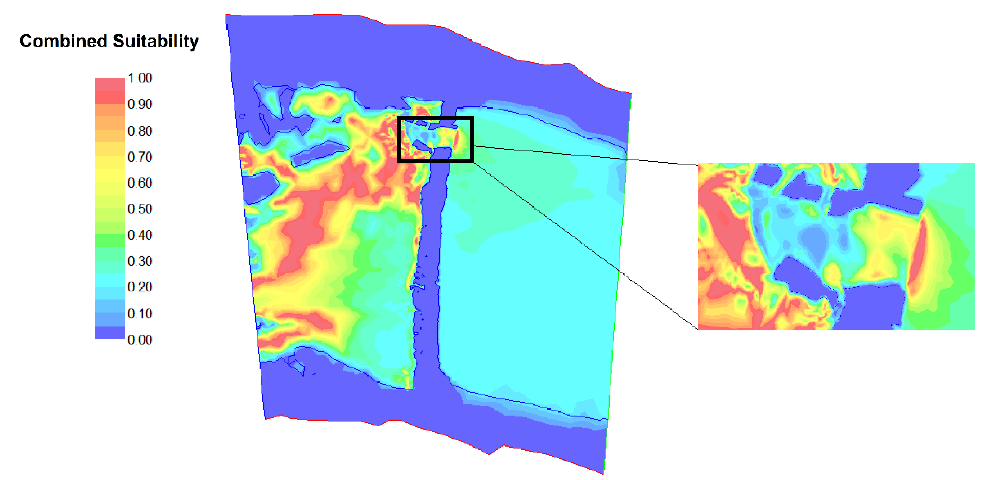
Figure 3. River2D output habitat suitability index for P. marinus (which displayed generally lower HSI values among the species present) in the Pego weir (left) and specifically at the fish ramp (right), for an inflow of 3 m 3 s −1 . Colored scales are presented for each case (HSI varying from 0-blue to 1-red, water depth from 0 to 5.32 m).